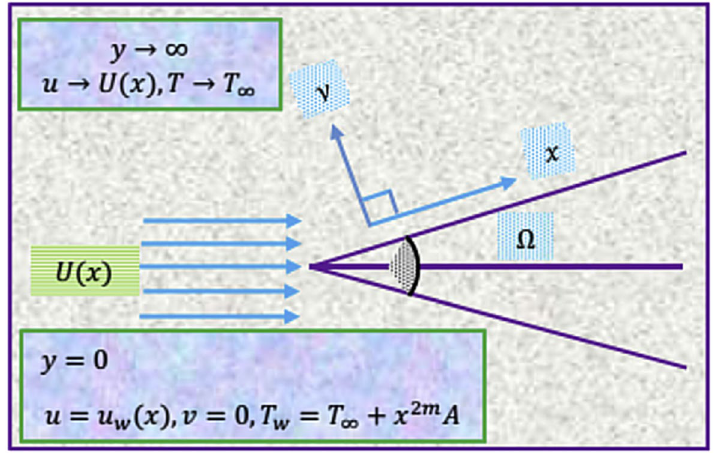
Figure 1. Nanofluid flow